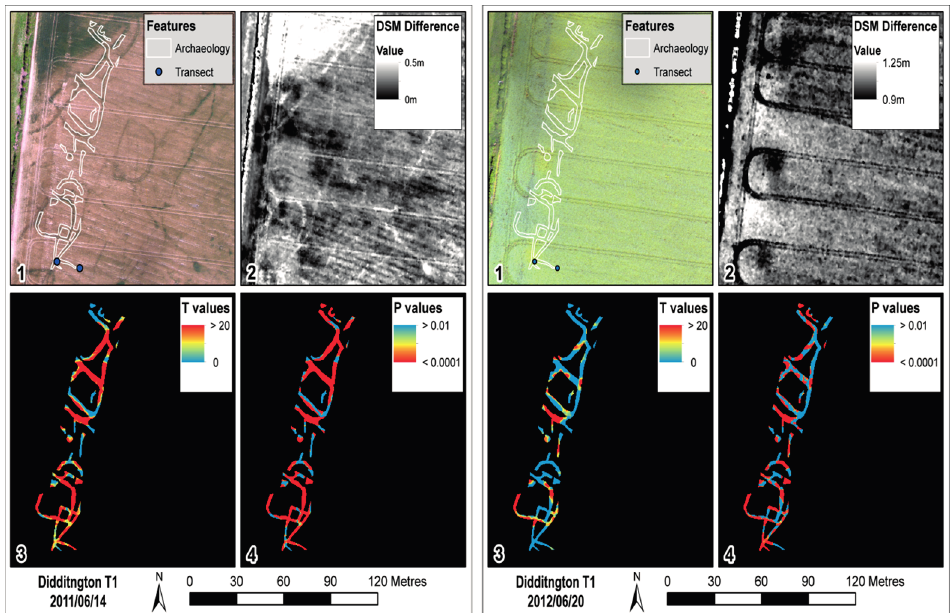
Figure 4. Multi-temporal airborne-LiDAR derived CHM for Diddington DDT1 field for Junes 2011 and 2012. (1) For comparison, aerial photography showing the locations of the archaeological features overlaid by those identified by magnetometer survey; (2) CHM data (referred to as difference in DSMs); (3) T -values indicating the strength of the localised contrast between the archaeological features and the background as exhibited by the CHM; (4) P -values indicating the localised statistical significance of the contrast.